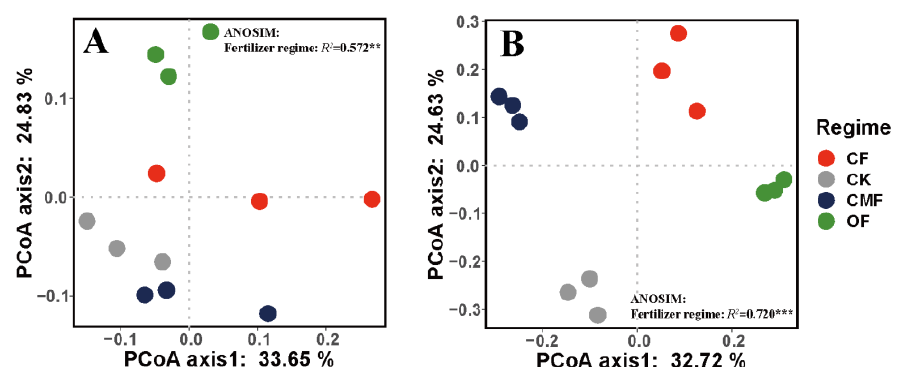
Figure 3. Principal coordinate analysis (PCoA) based on the Bray – Curtis dissimilarity matrices of bacterial ( A ) and fungal ( B ) communities. CK, control; CF, compound fertilizer; OF, organic fertilizer; CMF, compound microbial fertilizer. R 2 represents the variation in bacterial and fungal community composition that can be explained by the fertilizer regime, which was detected using ANOSIM. ** and *** denote the significant level at p < 0.01 and p < 0.001, respectively.